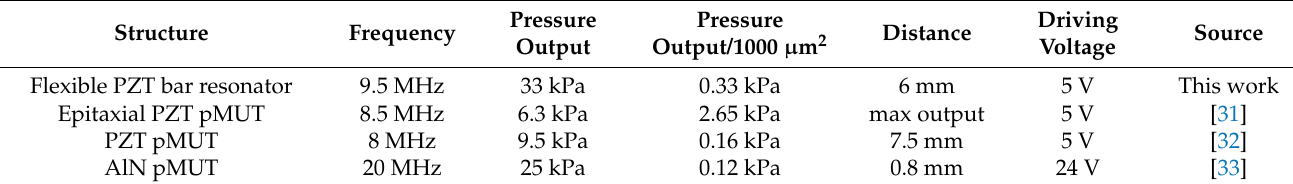
Table 1. Pressure output compared with rigid substrate-based piezoelectric micromachined ultrasonic transducer (PMUT) devices.